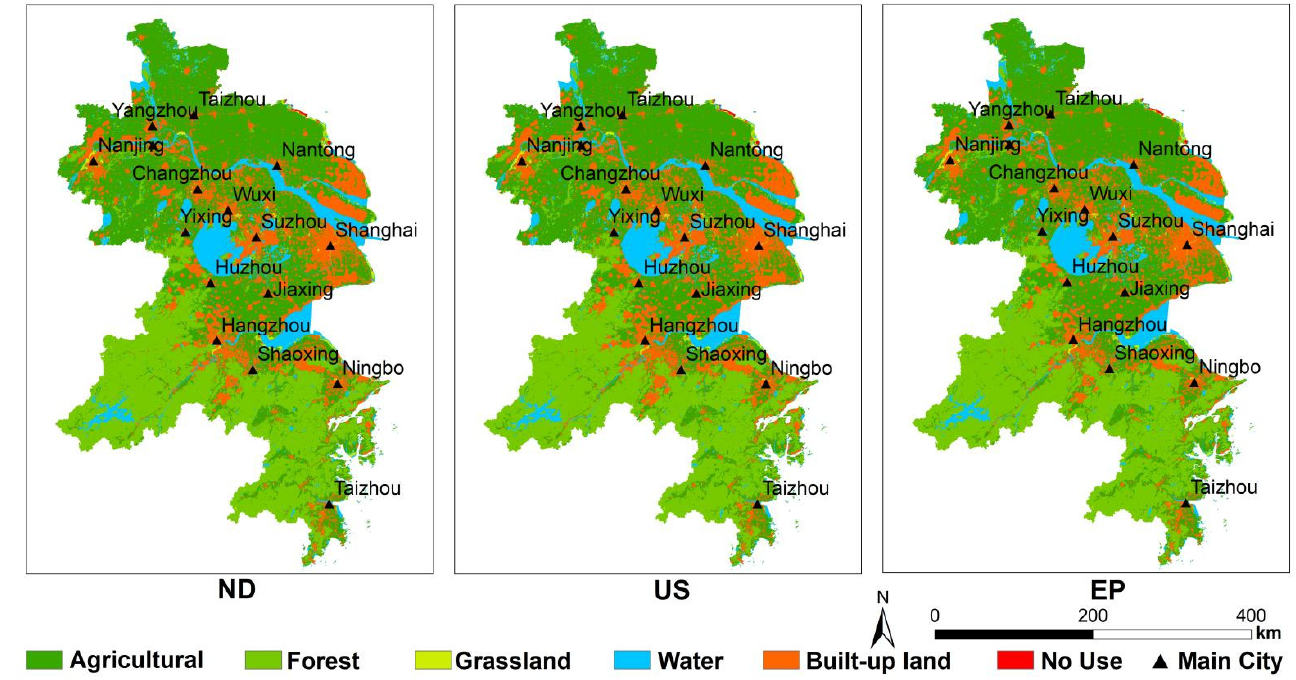
Figure 5. The land ‐ use types of the YRD under three scenarios. Figure 5. The land-use types of the YRD under three